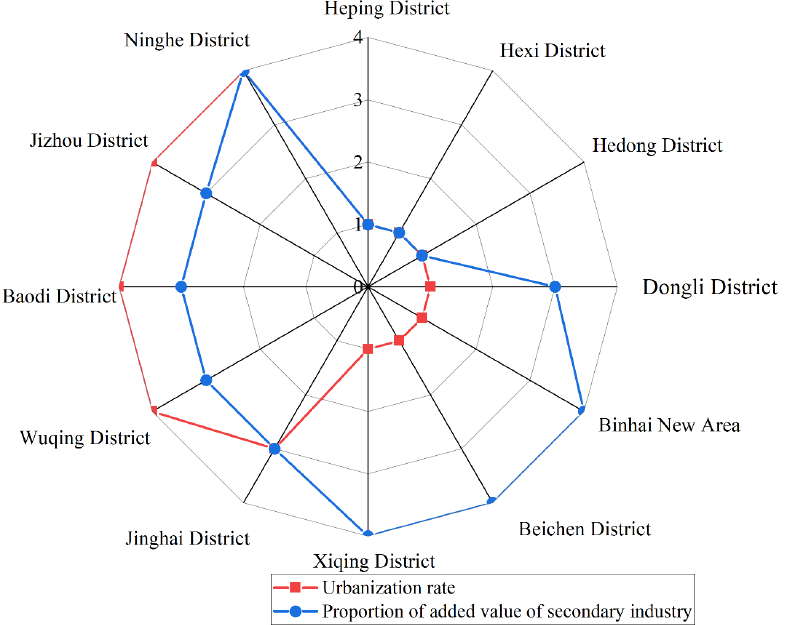
Figure 7 Figure 7. Spatial analysis chart of the proportion of added value between urbanization and secondary industry in Tianjin (Note: Due to missing data of Hexi District, Nankai District, Hongqiao District and Jinnan District, these areas are not included in Figure 7).